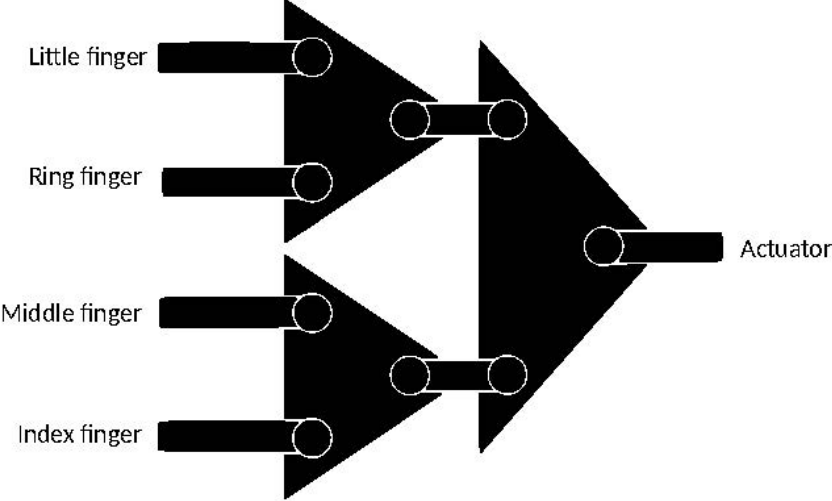
Figure 4. Whippletree mechanism proposed by Groenewegen [18].